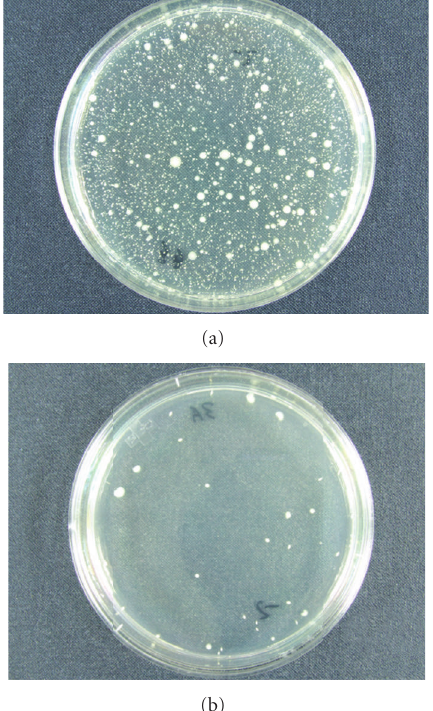
Figure 1: In in vitro experiments (a) bacterial colony plate in an agar dilution before insertion of povidone-iodine. (b) Bacterial colony plate in an agar dilution after biopsy; the mean number of colony-forming units decreased 99.9% after rectal